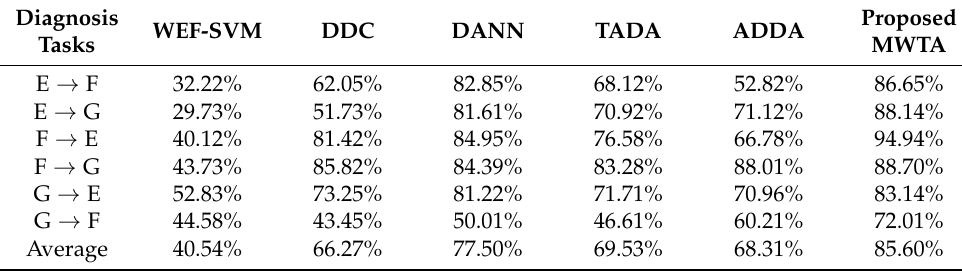
Table 7. The fault identification results of the proposed method and typical